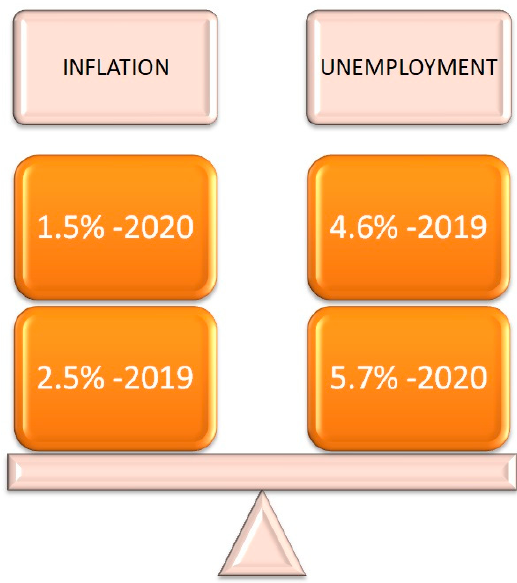
Figure 6. Comparison of inflation and unemployment 2019–2020 [24,25].